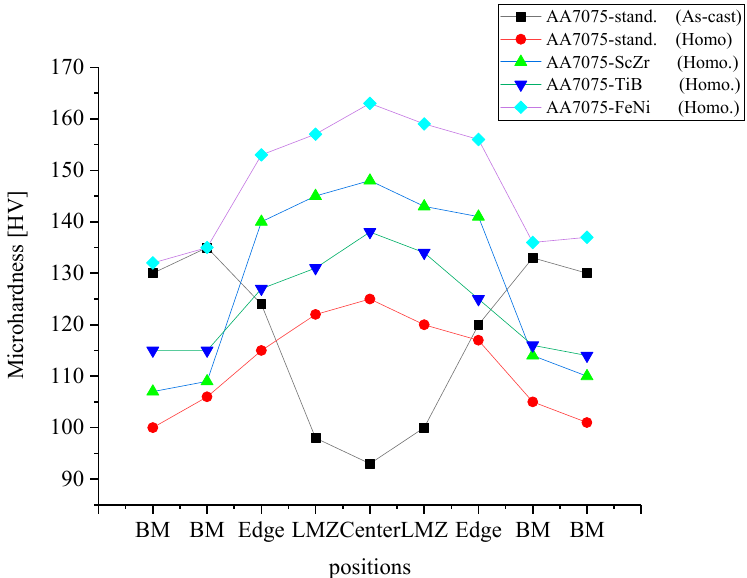
Figure 11. Microhardness results of alloys after laser processing along the base metal (BM) and LMZ.